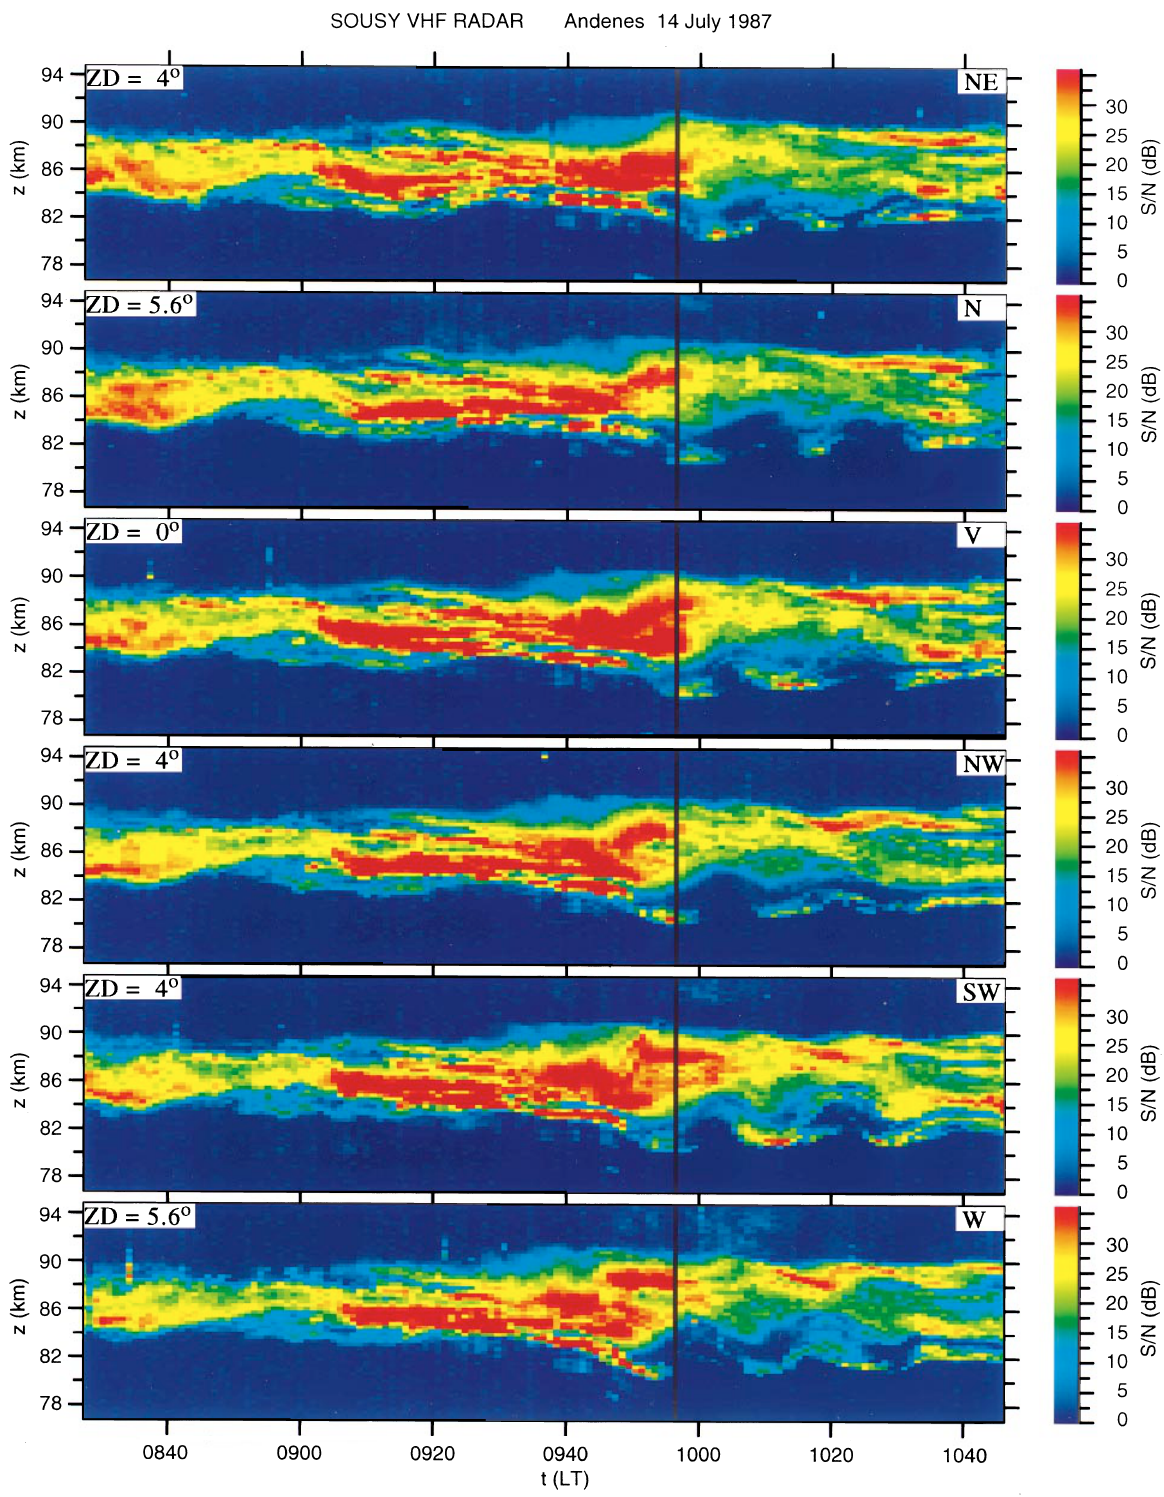
Fig. 1. Height-time plots of the echo intensity observed in six di(cid:128)erent beam directions on 14